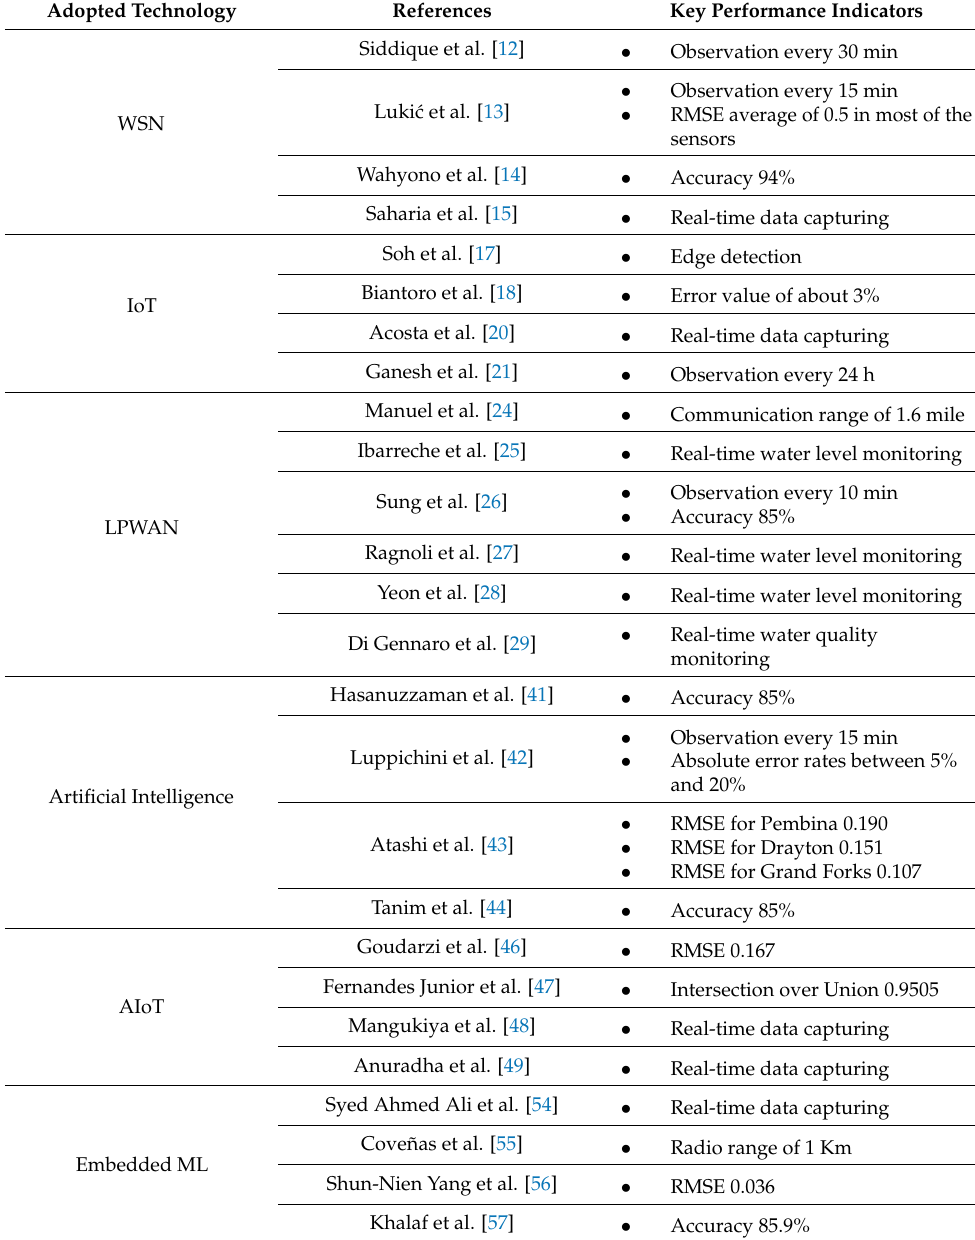
Table 1. Summary table of the literature